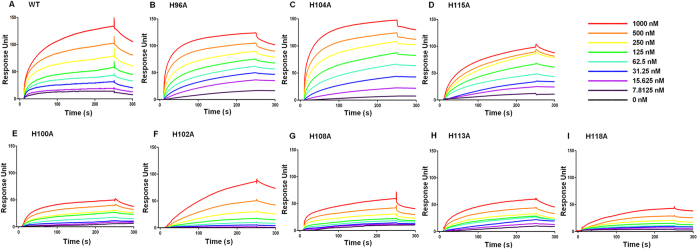
Surface plasmon resonance (SPR) assay of specific binding affinities of WT and histidine mutants to immobilized TLR4.After immobilization of TLR4 on the CM5 sensor chip surface, WT and histidine mutant samples were injected over immobilized TLR4 at a flow rate of 30 μl/min at 25 °C. PBS with 0.05% P20 running buffer was injected, and the response in resonance units recorded for 240 s as a function of time. Protein samples were replaced in running buffer for 480 s for disassociation of bound HpGroES. SPR sensograms were obtained after injection of serial dilutions of WT (A) and histidine mutants (B–I) (concentration: 0–1000 nM, top right) in running buffer. Data are representative of three independent experiments. The Kd and Bmax values of protein samples are shown in Table 2.